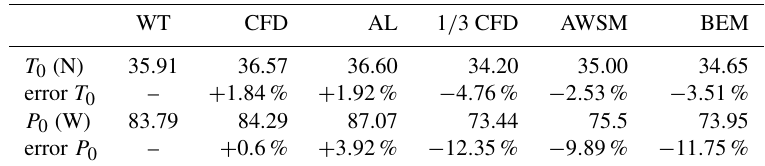
Table 3. Comparison of the steady-turbine model performance in RATED conditions.